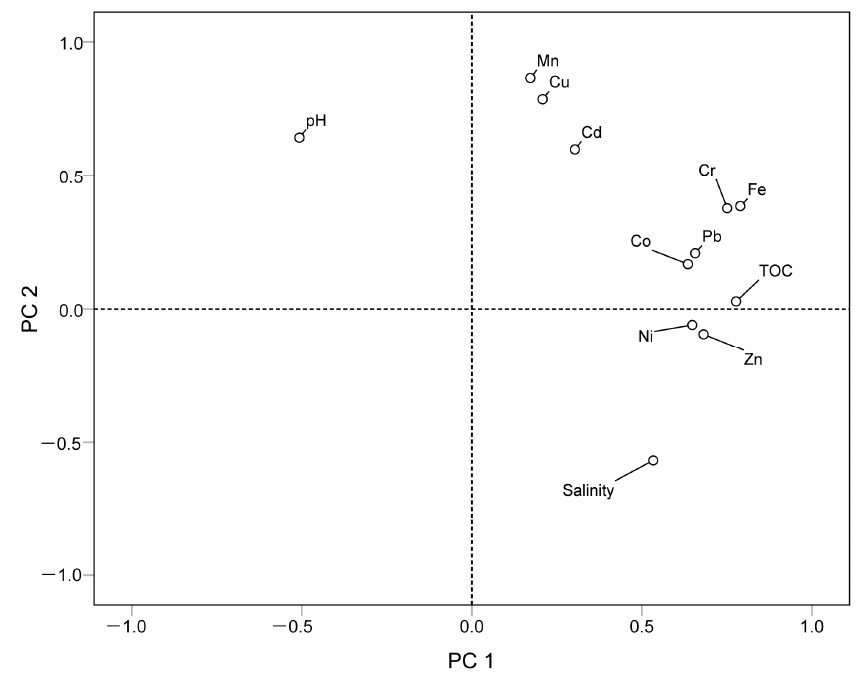
Figure 8. PCA loadings of components 1 and 2 for the nine heavy metals in surface sediments from the Qinjiang River.